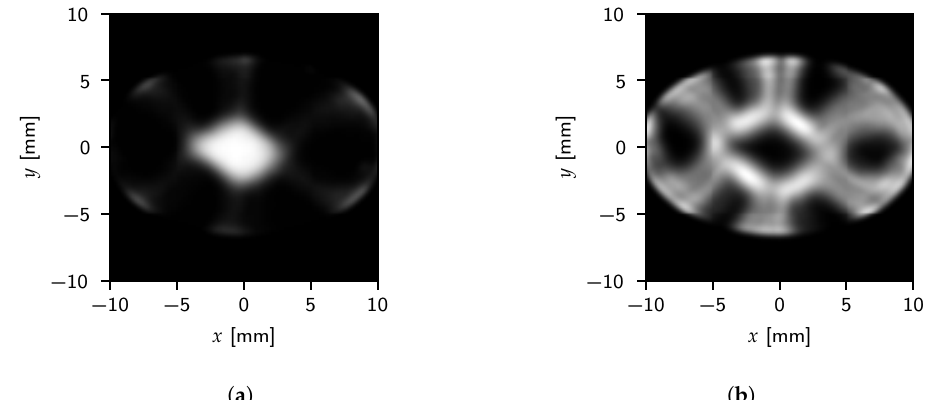
Figure 16. Time-averaged results for the elliptical outlet using ( a ) density and ( b ) color gradient magnitude. The density and color gradient magnitude image intensity maps to a range of 0 to 220 kg/m 3 and 0 to 0.09 m 2 /kg, respectively.